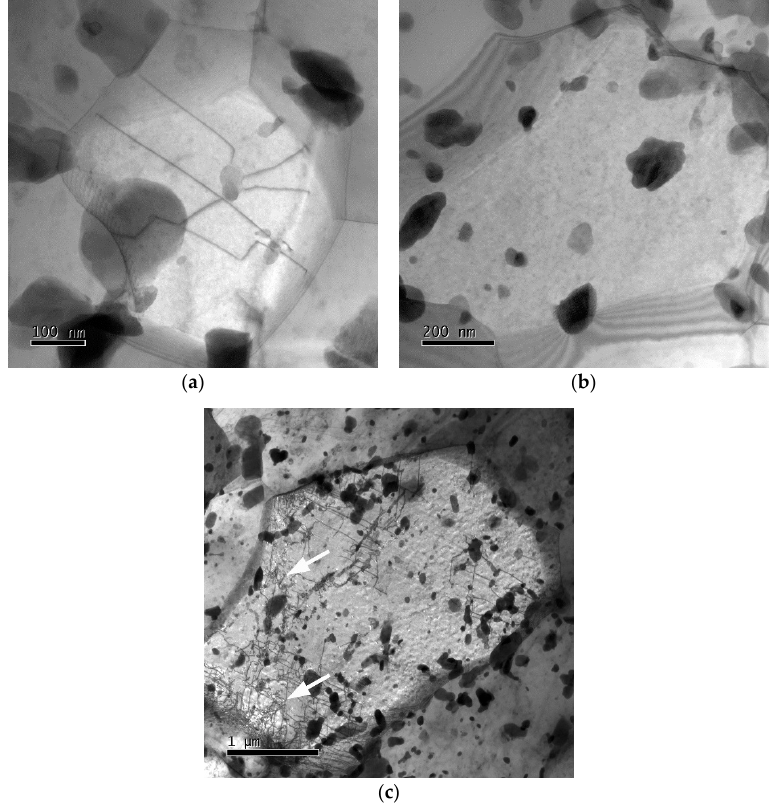
Figure 12. Dislocation microstructure in the HPS15-processed specimen tested at 873 K and 100 MPa in gauge length with ( a ) ε loc ~0.03–0.05 (fine grain), ( b ) ε loc ~0.03–0.05 (large grain), and ( c ) ε loc ~ 0.2.